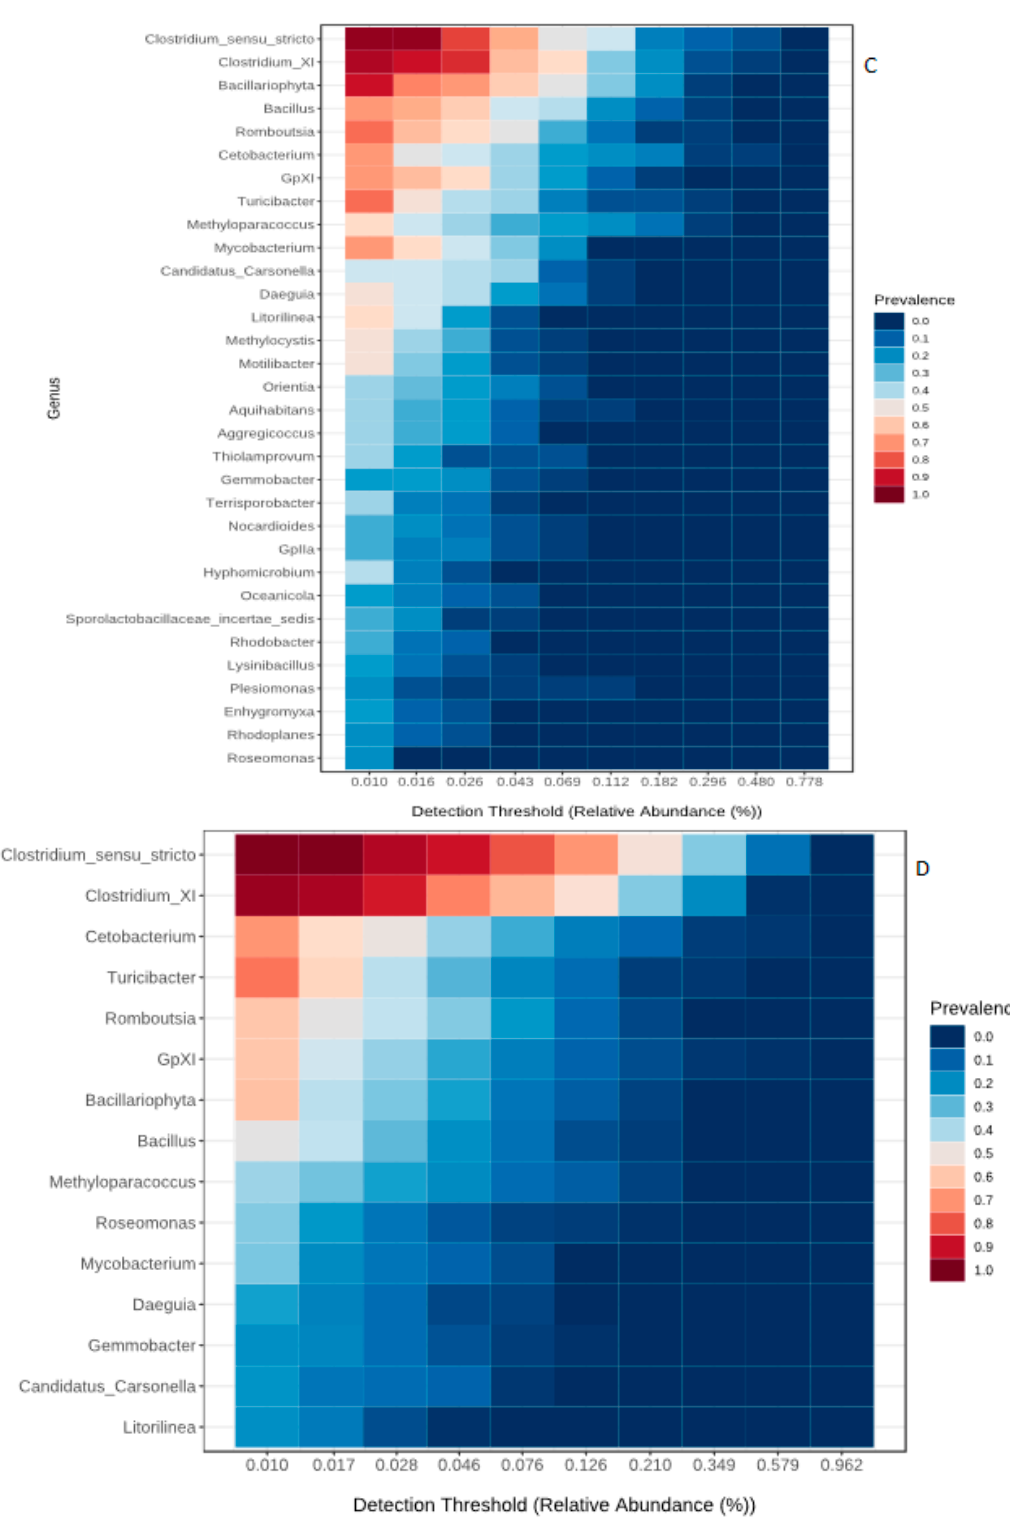
Figure 5. Heatmap representing the core microbiome at Genus level. Core microbiome at stomach region ( A ), hind gut region ( B ), midgut region ( C ) and the shared microbiome among the regions ( D ).